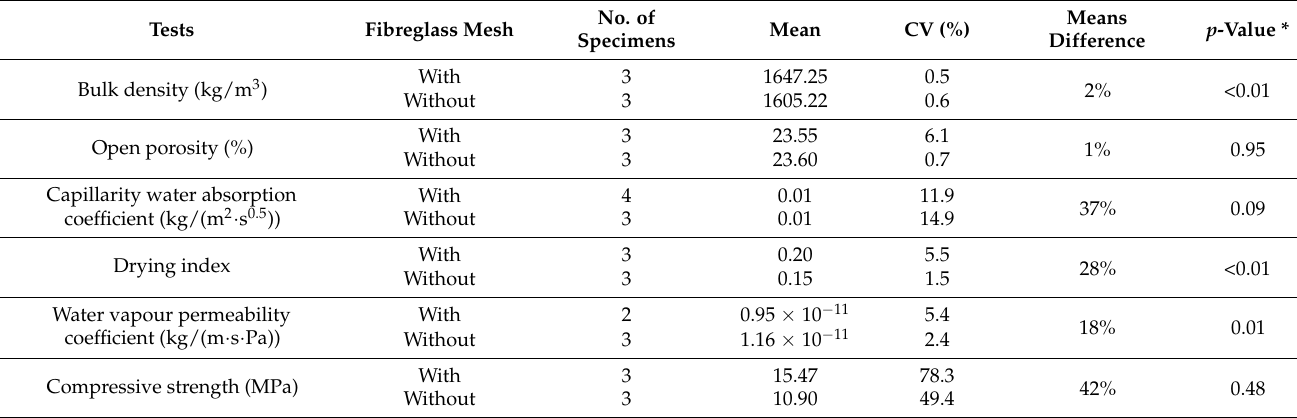
Table 12. Air lime mortar applied to the solid ceramic brick substrate.